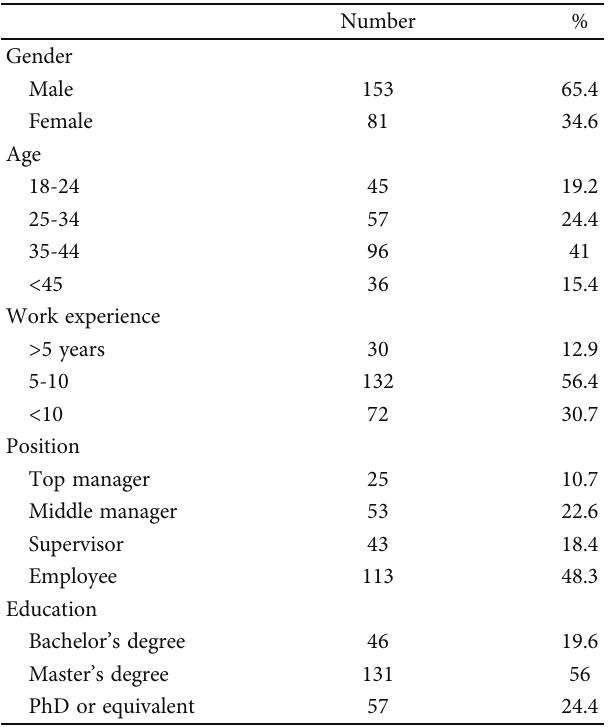
Table 2: Demographic features of the sample. Table 3: The results of validity and reliability tests of the